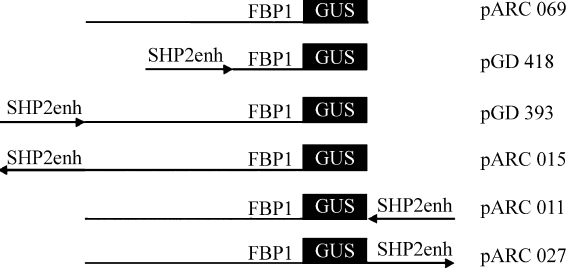
Figure 2 - Schematic representation of the constructs in which the SHP2 enhancerwasfusedtothe pFBP1::GUS promoter-geneconstructindiffer- ent orientations. pARC069: the pFBP1::GUS construct used as control. pGD418: SHP2 in sense orientation upstream of the short version of the pFBP1 promoter. pGD393: the SHP2 enhancer fragment is located up- stream of the long pFBP1::GUS version. pARC015: the SHP2 is also lo- cated upstream of the long pFBP1::GUS construct, however in antisense orientation.pARC011:the SHP2 isplaceddownstreamofthe GUS genein sense orientation and SHP2 is placed in antisense orientation in the same long version of the FBP1 promoter, in pARC027. This schematic repre- sentation is not drawn to